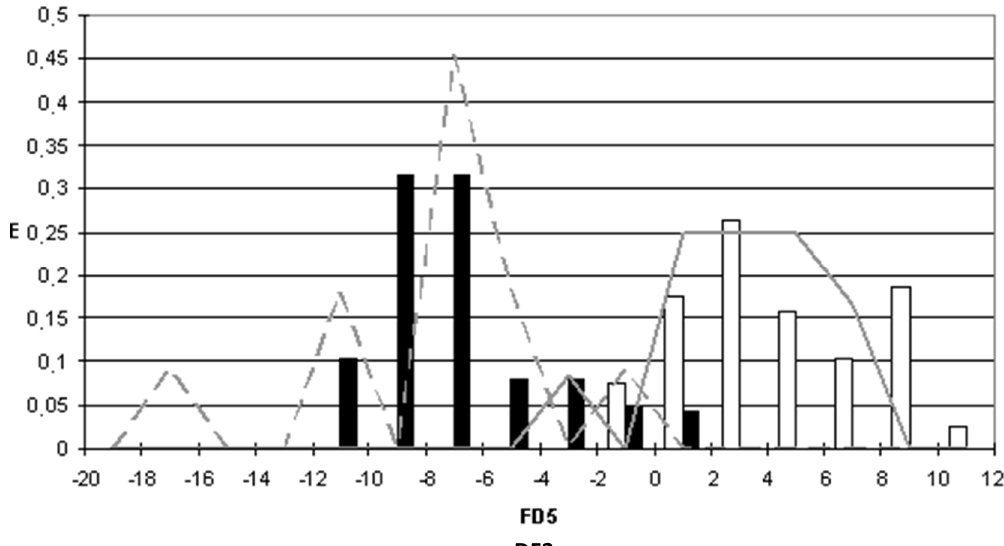
Figure 3. DF3 pharmacological distribution diagram. Black bars: Training Inactives. White bars: Training Actives. Dashed line: Test Inactives. Straight line: Test Actives.